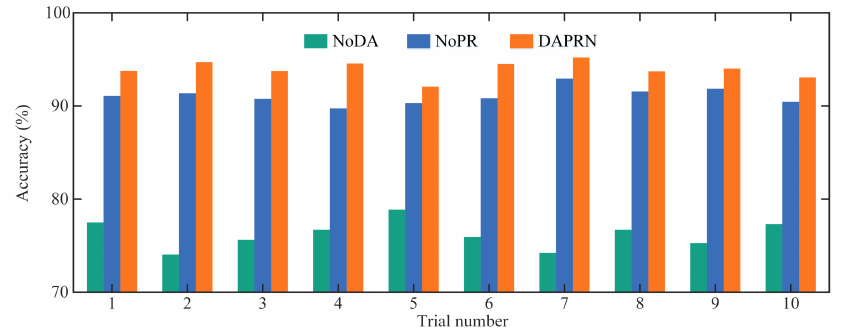
Figure 11. Detailed testing accuracy of ten trials using various models on task BB3.